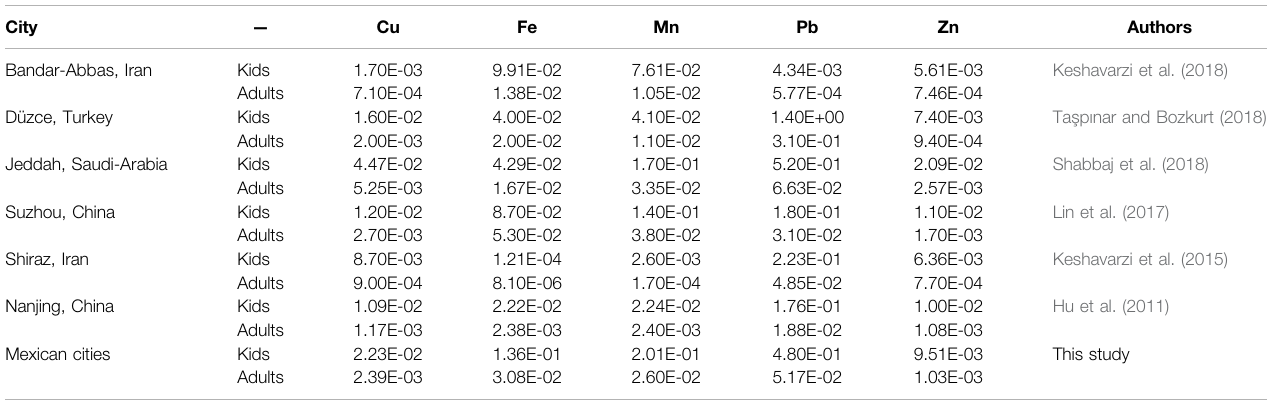
TABLE 1 | Comparison of mean Hazard Index (HI) for the studied heavy metals in other cities around the world. City — Cu Fe Mn Pb Zn